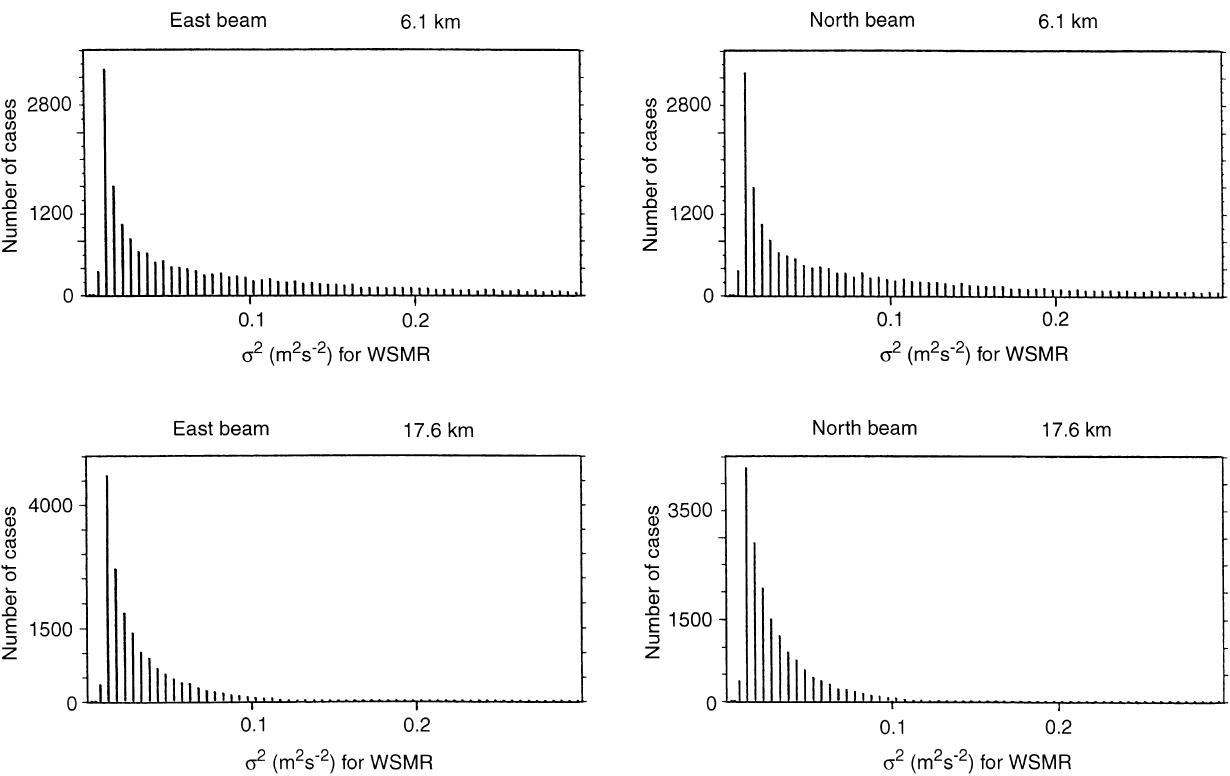
Fig. 10. Frequency distributions of the values of (cid:114) 2 computed with (15) using the observed wind speeds and vertical wind shears